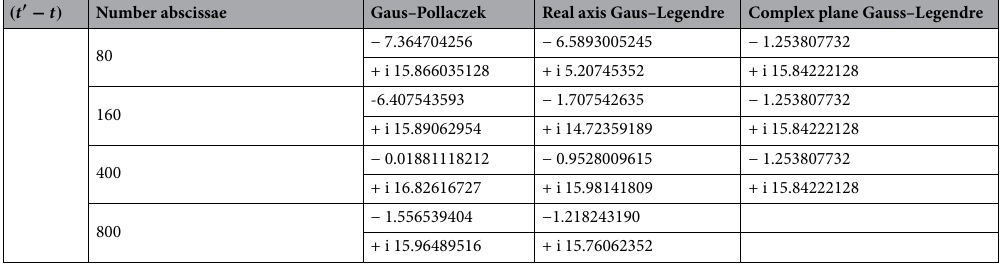
Table 4. Results for angular momentum l = 1 . Same as Table 3 but with l = 1.